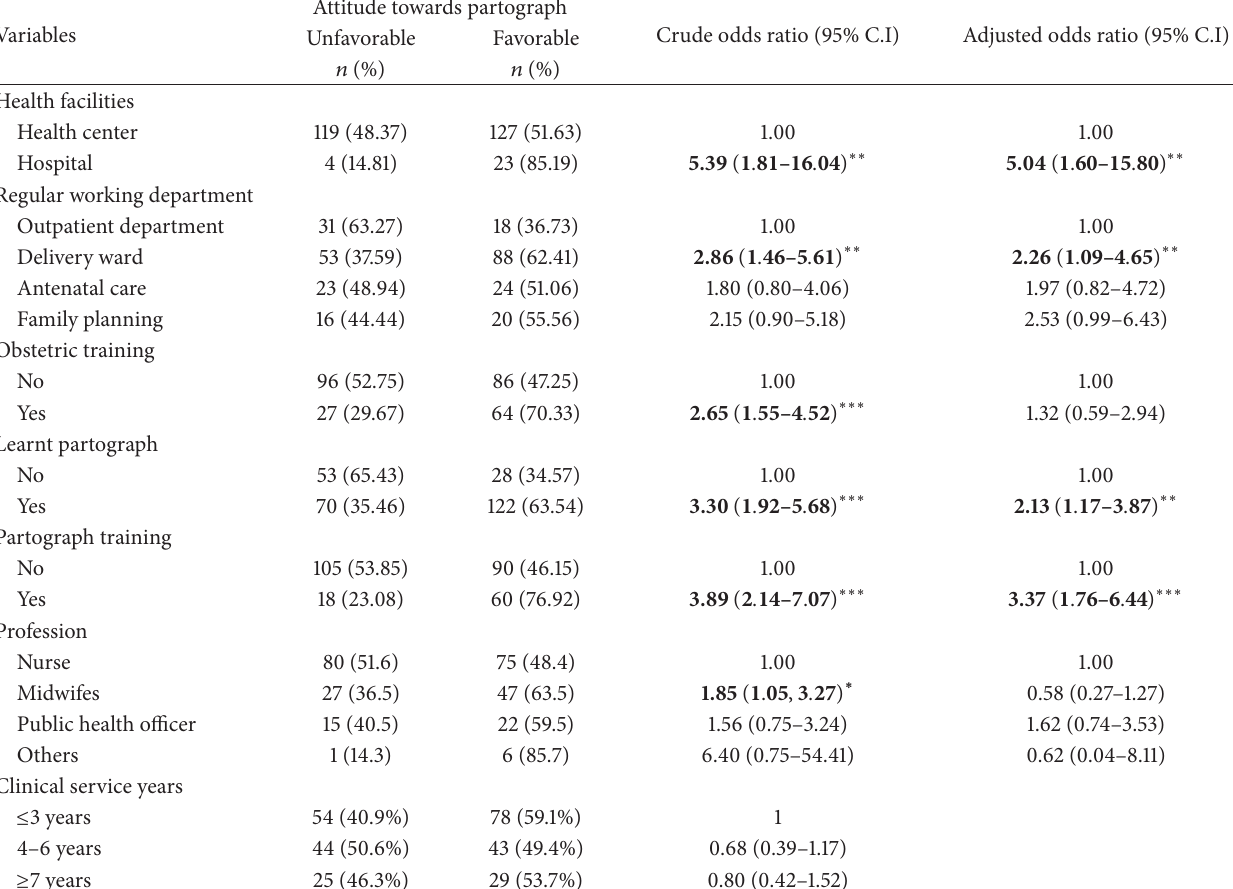
Table 7: Factors associated with attitude towards partograph, East Gojjam Zone, Northwest Ethiopia, 2015 ( 𝑛 = 273 ).